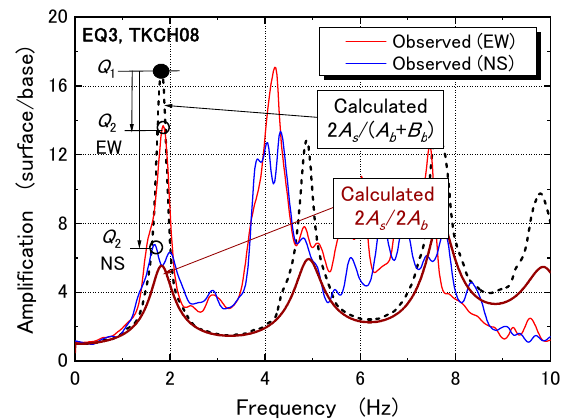
Figure 11. Example how to determine peak value of 2 A s /2 A b from 2 A s /( A b + B b ) compared with observed spectrum ratio.